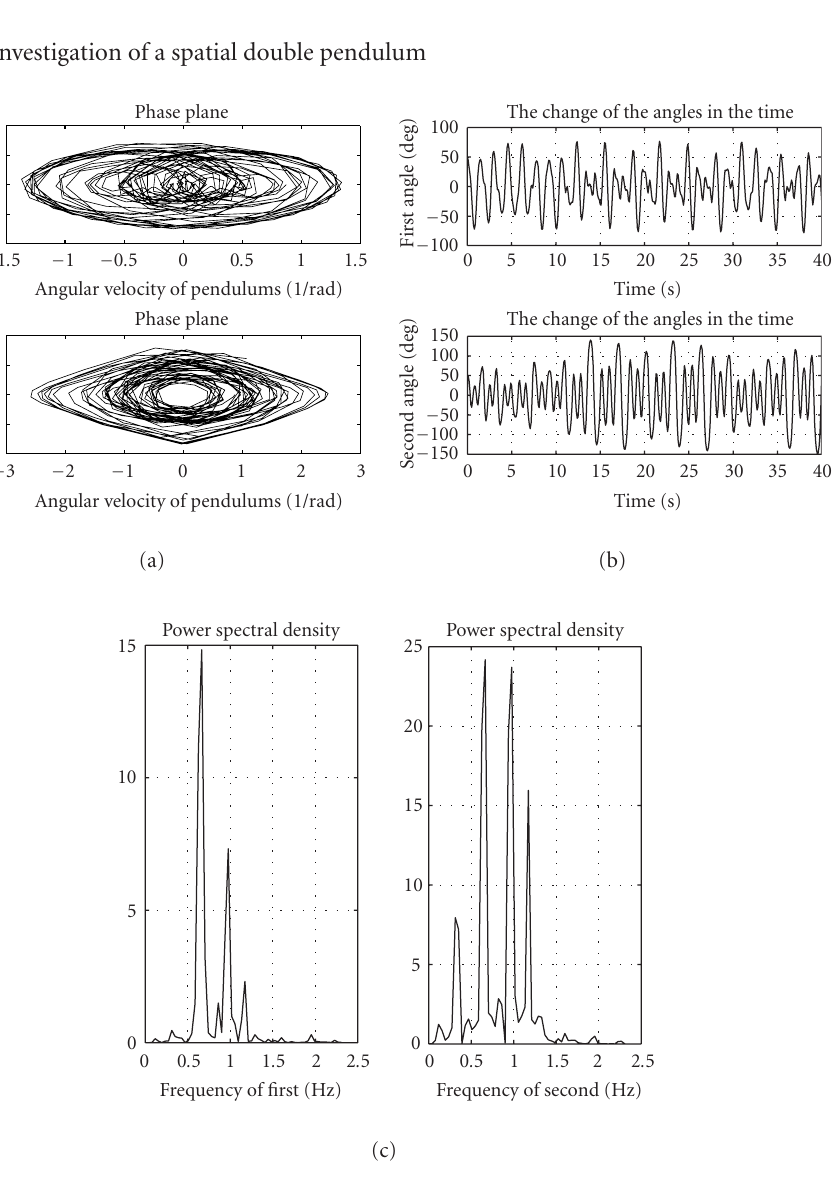
Figure 3.3. (a) “Phase portraits” for the two pendulums; (b) swinging angles ϕ 1 ( t ) and ϕ 2 ( t ); (c) oscillation spectrum distributions for the two pendulums. Parameters are m 1 = m 2 = 1 . 57 kg, L 1 = L 2 = 0 . 3 m, Ψ = 30 ◦ . Initial conditions are ϕ 1 = 50 ◦ , ϕ 2 = 50 ◦